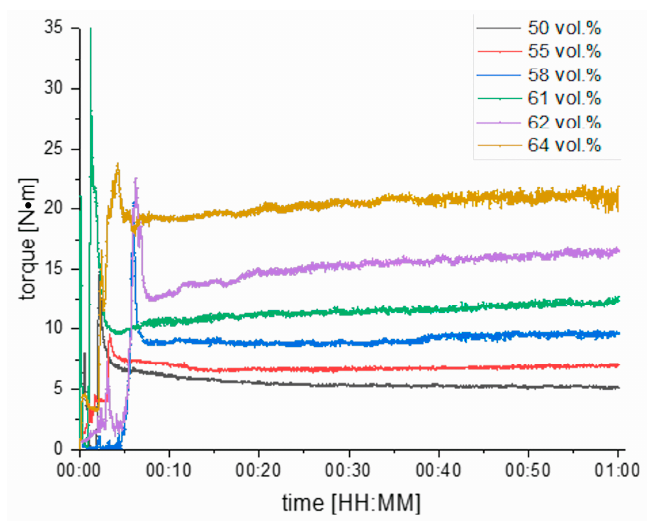
Figure 6. Mixing characteristics of PVB- / PEG-based molding compounds with di ff erent filler degrees of alumina powder.